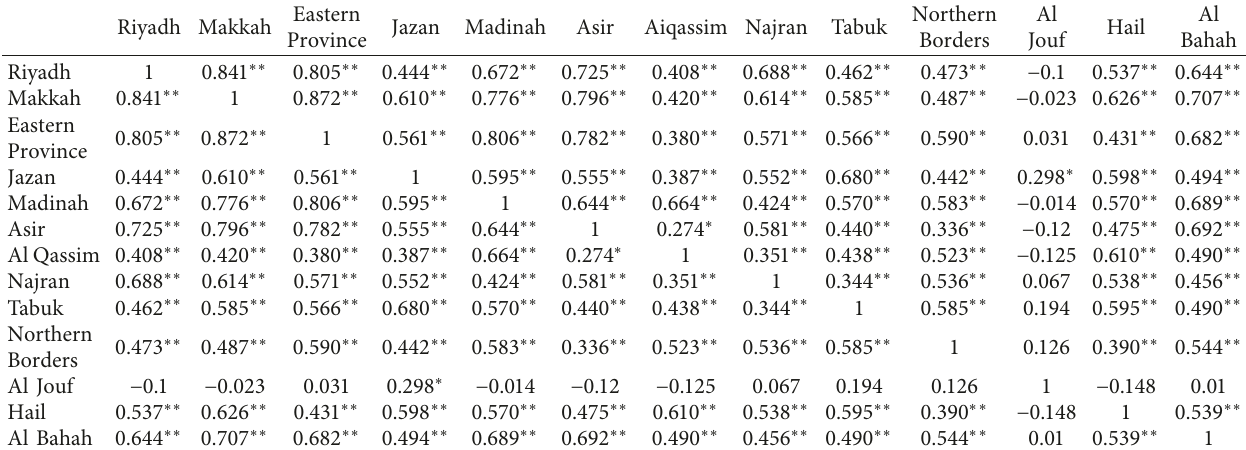
Table 3: Correlation matrix